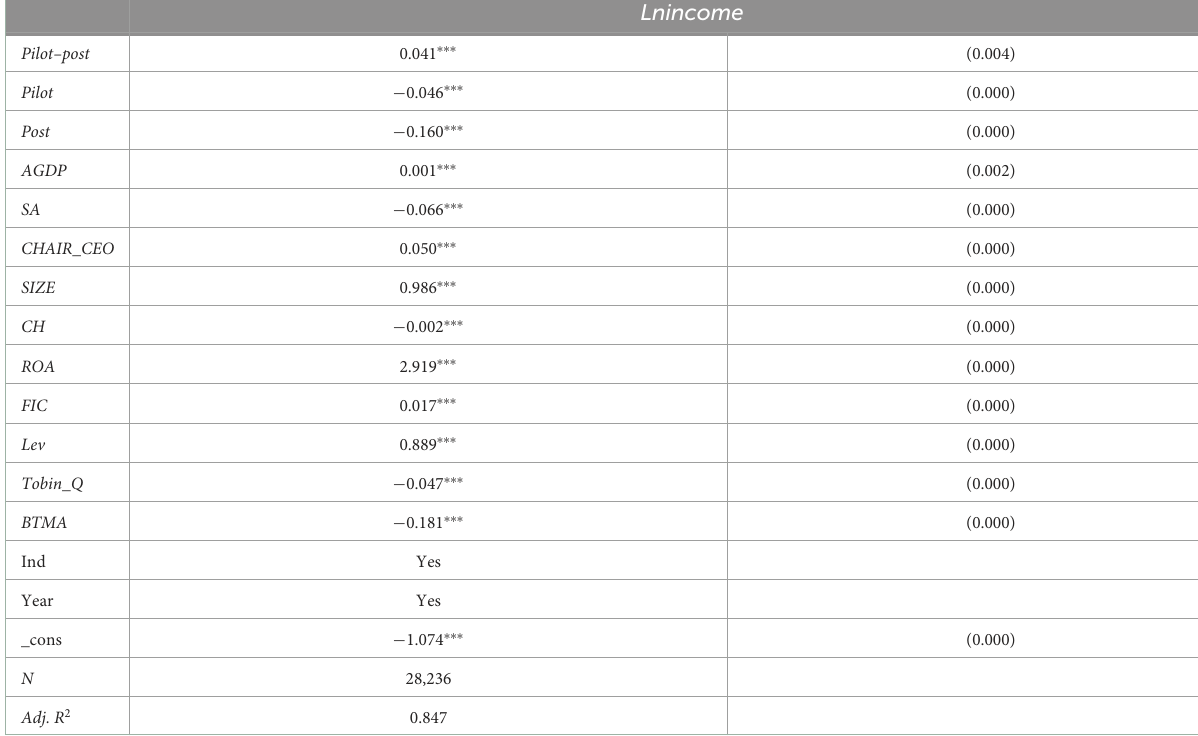
TABLE 6 Impact of low-carbon city pilot policy on enterprises’ sales revenue.